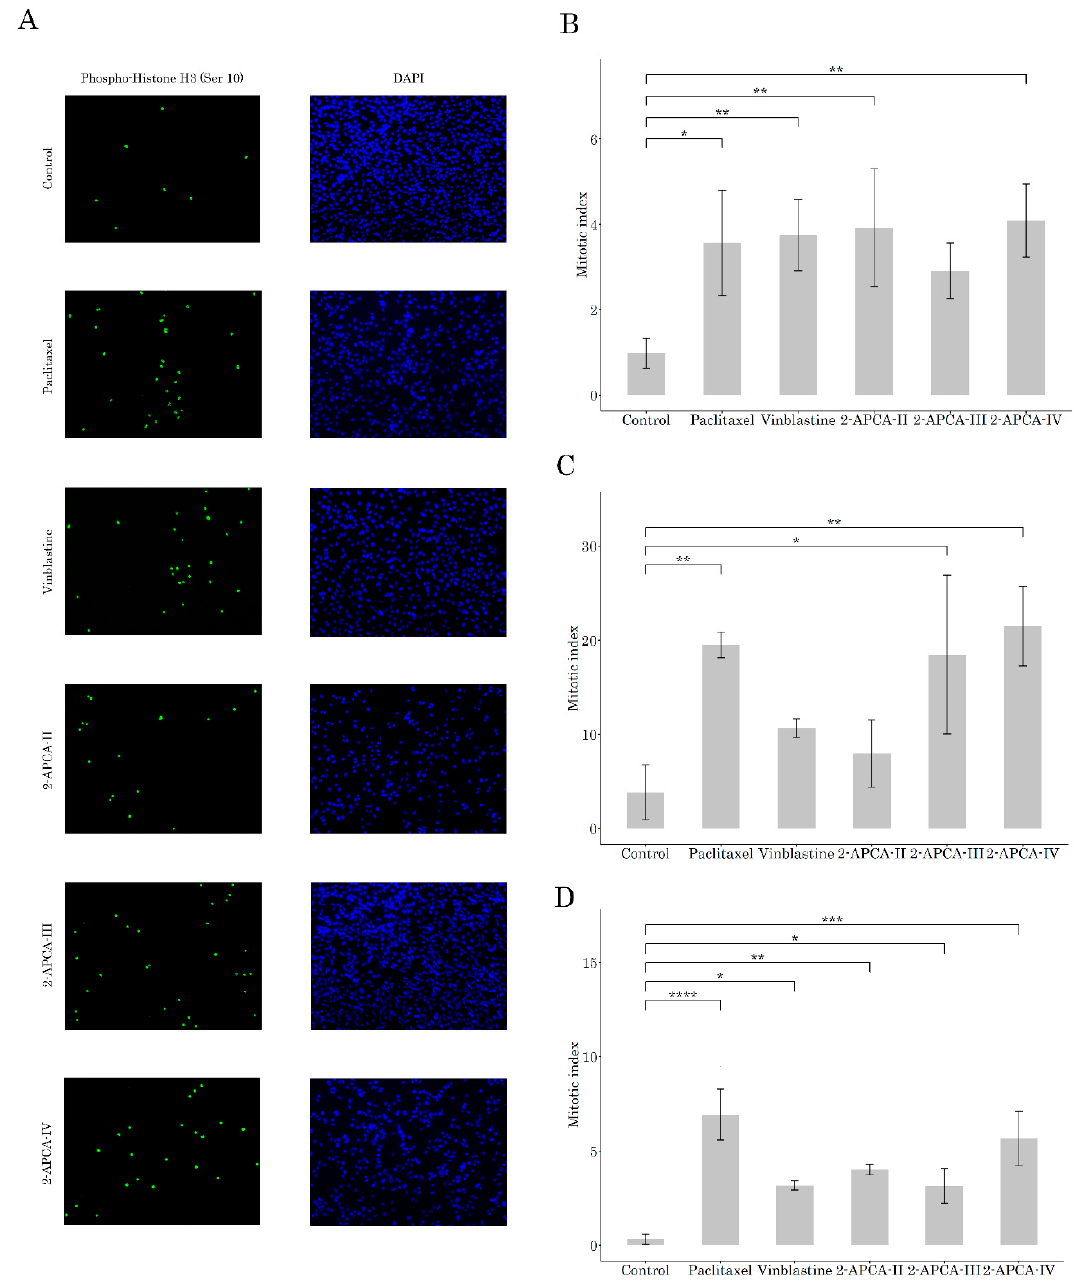
Figure 3. The 2-APCAs induce the accumulation of cancer cells in the M-phase. ( A ) The representative immunofluorescence images (40 × ) of RD cells treated with DMSO (negative control), 2-APCAs (10 µ mol), paclitaxel (0.1 µ mol), vinblastine (0.01 µ mol), and immunostained using the Alexa488 labeled phospho-histone 3 (Ser10) antibody. DAPI nuclear staining was used to outline an equal number of cells. ( B ) Graph depicting the number of mitotic cells after 2-APCAs treatment from 3 independent experiments. Cells treated with DMSO, paclitaxel, and vinblastine were used as the negative and positive controls, respectively. ( C ) Quantitative analysis of mitotic cells in H1299 lung cancer cells treated with DMSO (control), 2-APCAs, paclitaxel, and vinblastine. ( D ) Quantitative analysis of mitotic cells in MDA-MB-231 breast cancer cells treated as indicated above. * p < 0.05; ** p < 0.01; *** p < 0.001; **** p < 0.0001.